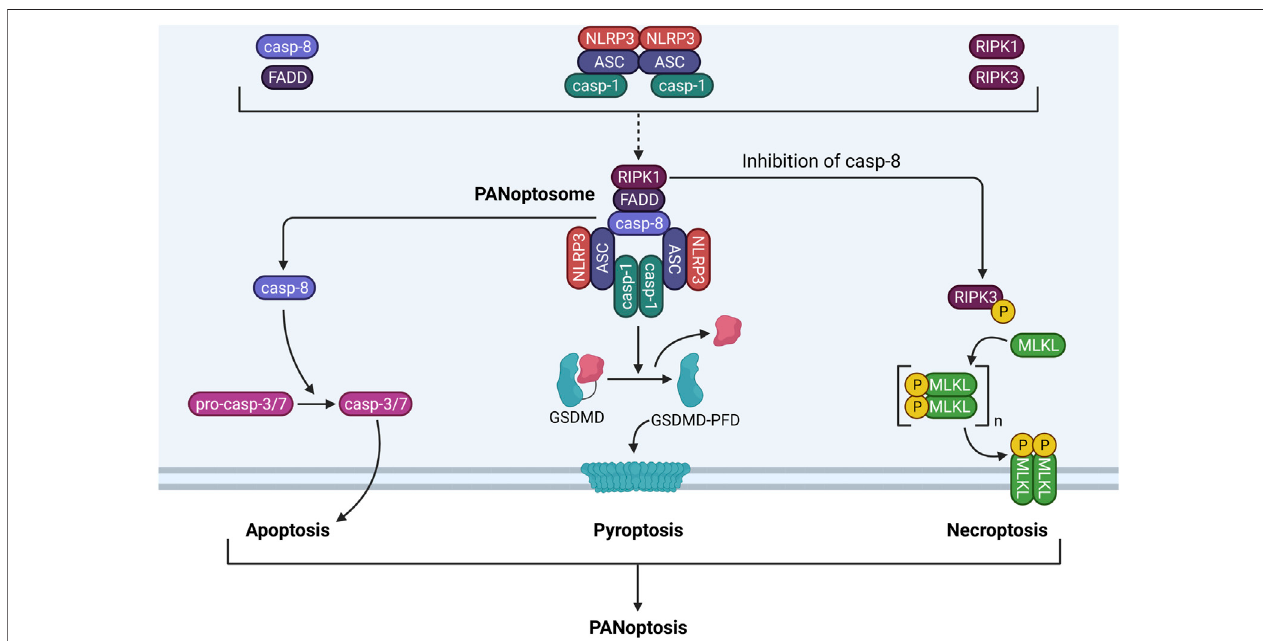
FIGURE5| PANoptosomecomponentsandfunctionality.ThePANoptosomeisamultiproteincomplexconsistingofmoleculesfromtheapoptotic,pyroptotic,and necroptotic celldeathpathways.Exposuretoaproin fl ammatorystimulussuch as LPScausesupregulation and activationofapoptotic proteins (i.e.,caspase-8, FADD), pyroptotic proteins (i.e., NLRP3, ASC, caspase-1), and necroptotic proteins (i.e., RIPK1, RIPK3). These proteins associate with one another to form the PANoptosome. Following assembly, the PANoptosome can execute apoptosis, pyroptosis, and necroptosis simultaneously by driving caspase-3/7 activation by caspase-8, GSDMD processing by caspase-1, and MLKL phosphorylation and pore formation by RIPK1 and RIPK3. Cell death by concurrent apoptosis, pyroptosis, and necroptosis is termed